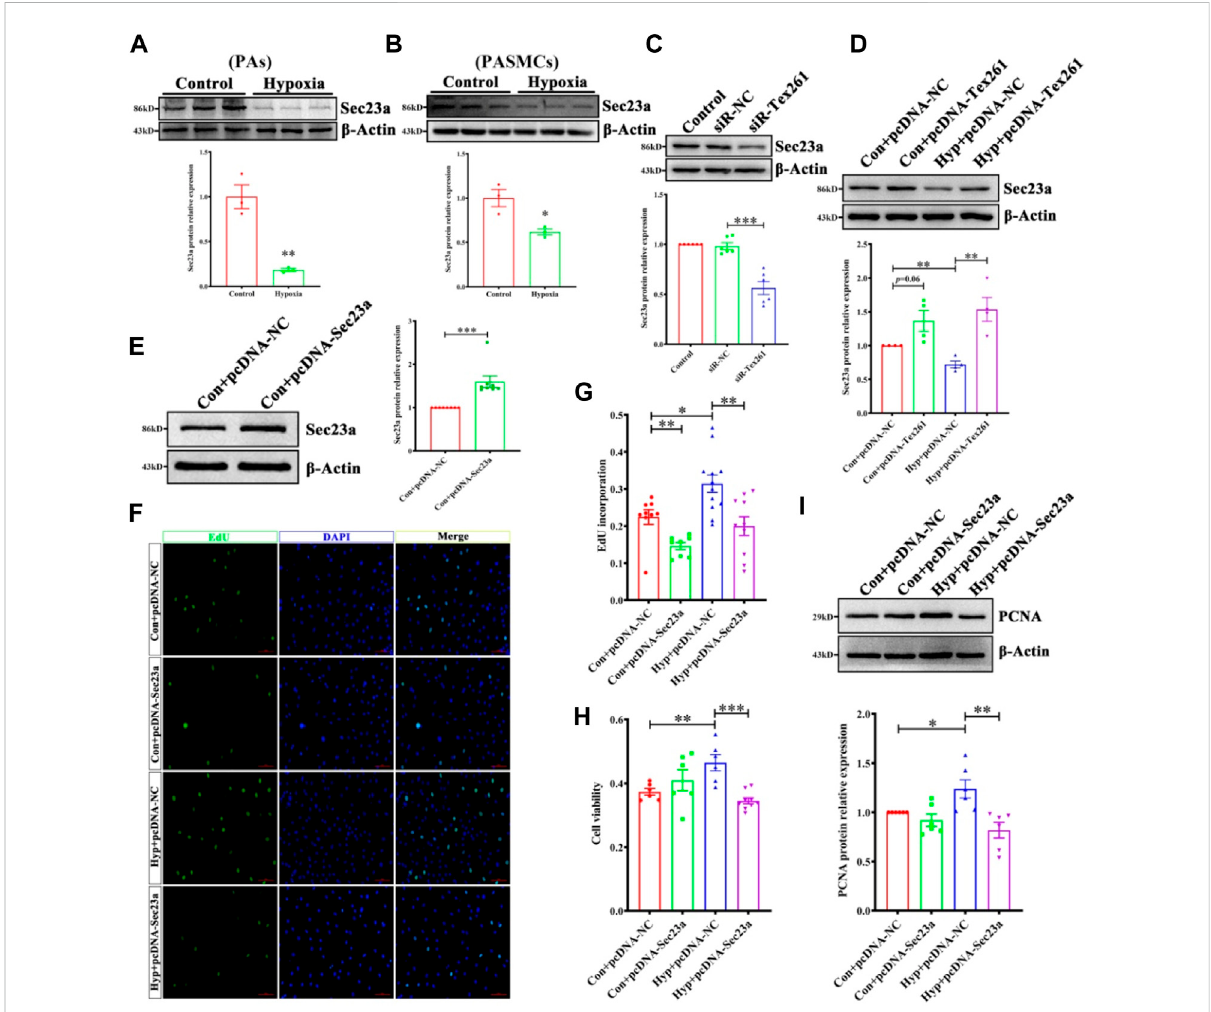
FIGURE 4 Sec23 is involved in Tex261-induced cell proliferation. (A,B) Sec23 expression was detected in hypoxic PAs and PASMCs ( n = 3). (C) After Tex261 inhibition, Sec23 expression in PASMCs was detected by Western blots ( n = 6). (D) After Tex261 overexpression, Sec23 was detected by Westernblots( n =4). (E) WesternblotresultsshowedthatSec23increasedaftertransfectionwithplasmidsinPASMCs( n =8). (F,G) Theproportionof PASMCs proliferating was detected by EdU assays and observed by ×20 magni fi cation ( n = 6). (H) Cell viability was detected